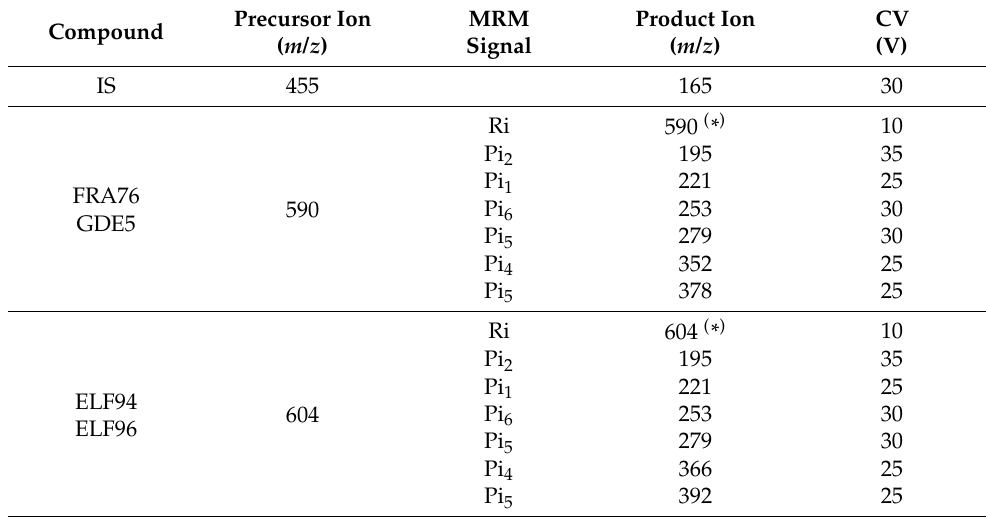
MRM Product Ion Signal ( m / z )